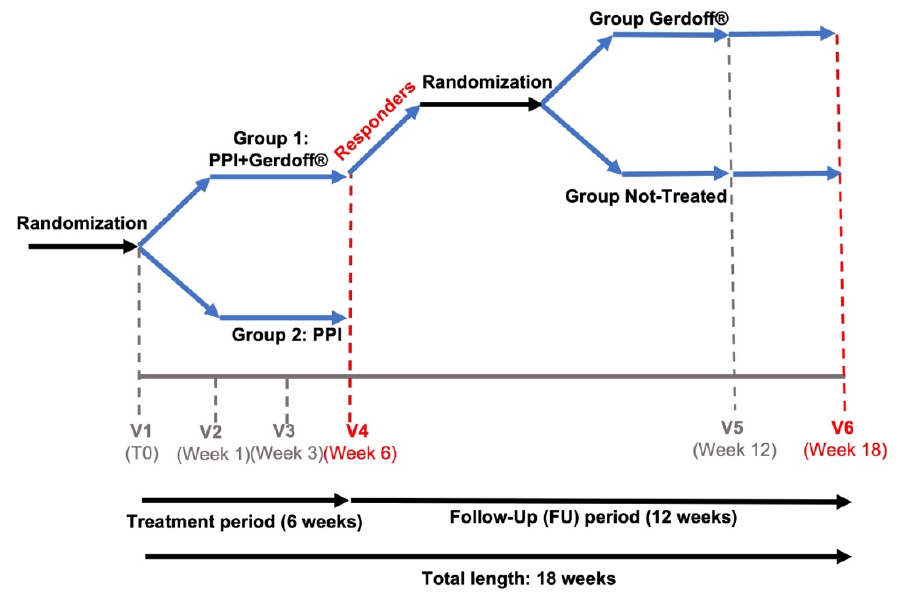
Figure 1. Study diagram. At baseline visit (visit V1), the enrolled patients were randomized with a 1:1 ratio in one of treatment groups: Group 1 (PPI + Gerdoff ® ) or Group 2 (PPI; control group). After the treatment period (6 weeks), the responders of Group 1 were further randomized with a 1:1 ratio in one of following groups defined according to the treatment: Group Gerdoff ® or Group Not-Treated. At week 12 from visit V1 (visit V5), the treatment was interrupted. The assessment of treatment effect maintenance was prolonged for a 6-week follow-up period (visit V6: week 18 from visit V1); PPI, proton pomp inhibitors.